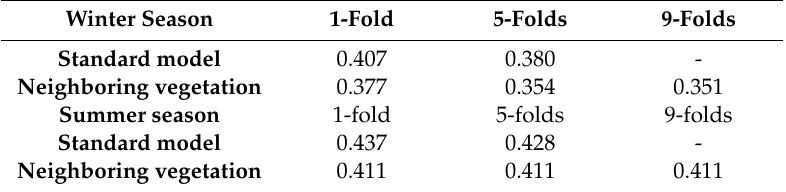
Table 3. Root mean square error based on the di ff erence between the predicted and observed